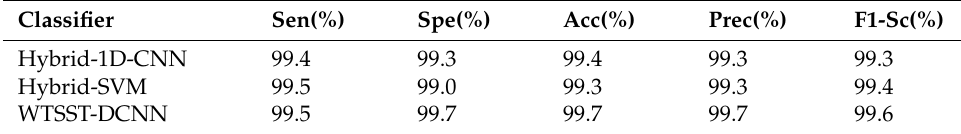
Table 6. Comparison between DNN and SVM for hybrid features and